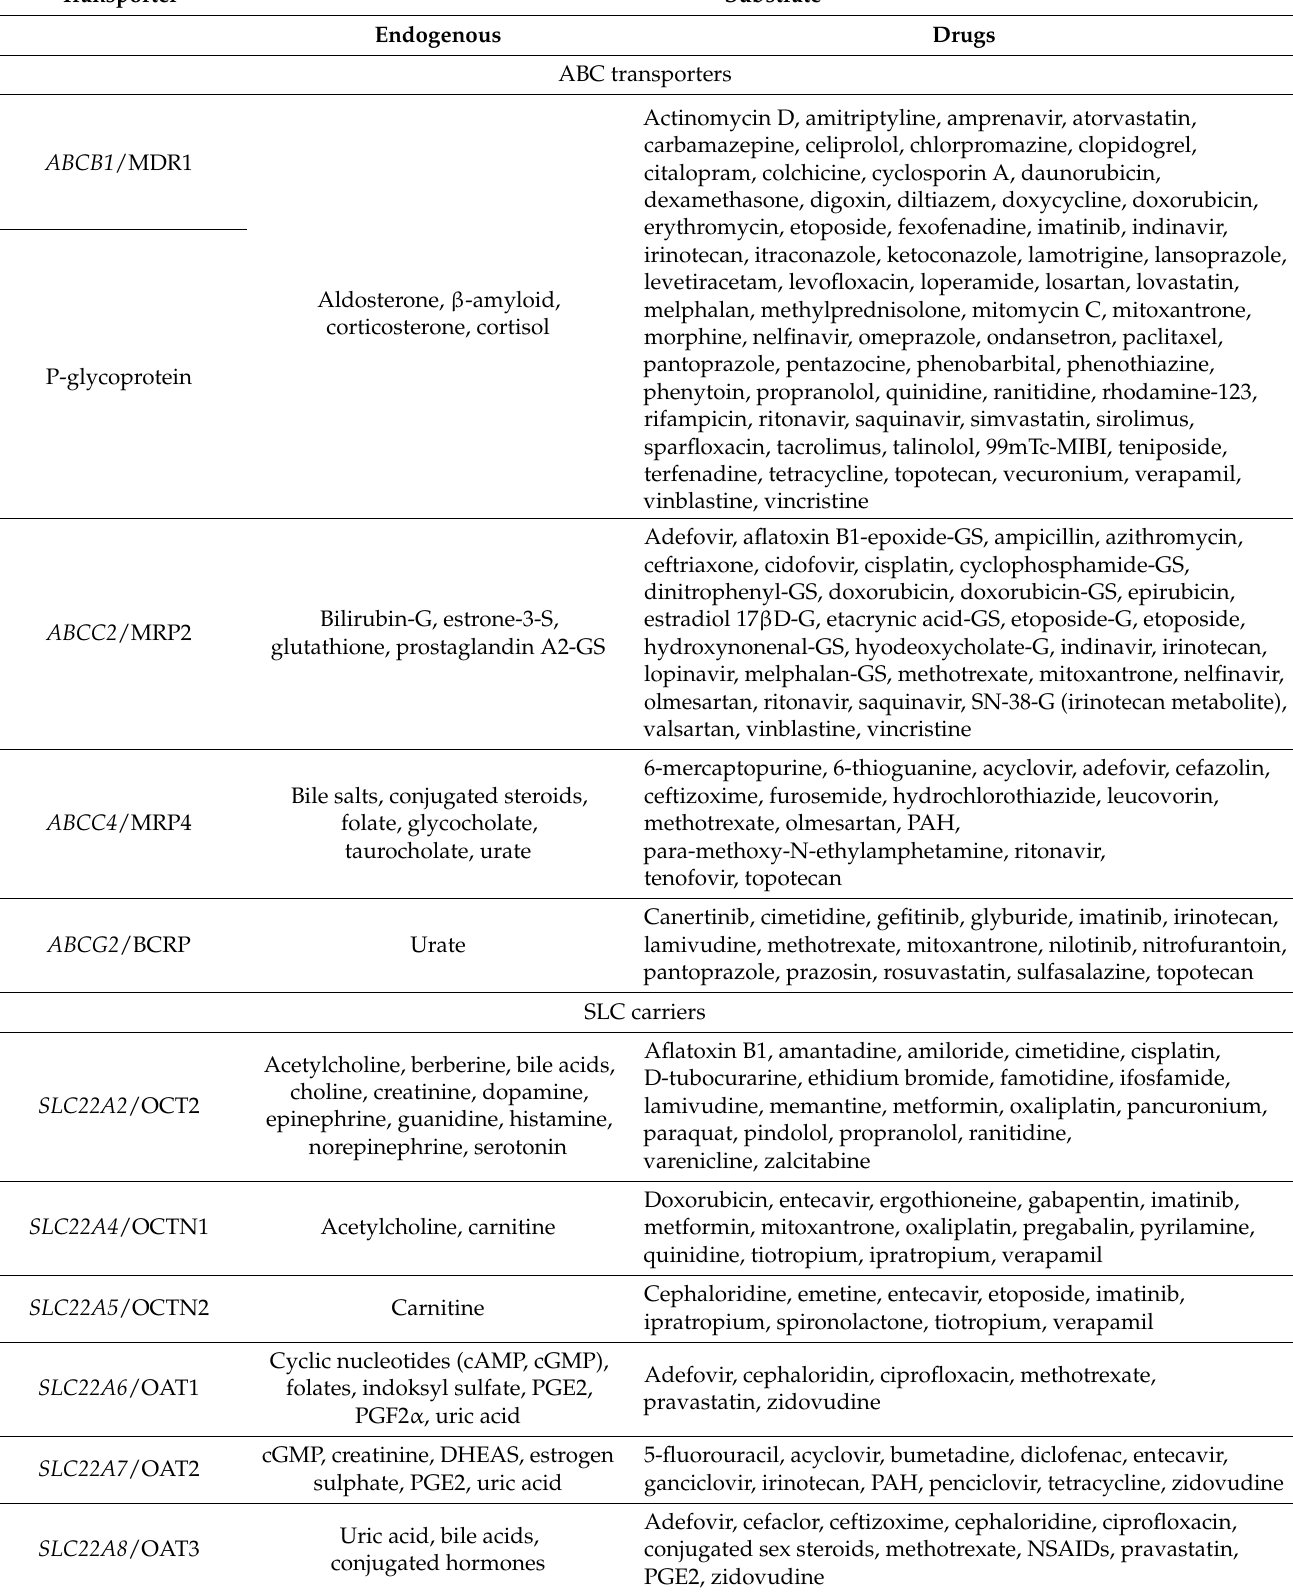
Table 1. Selected substrates of the main transporters and carriers presented in the